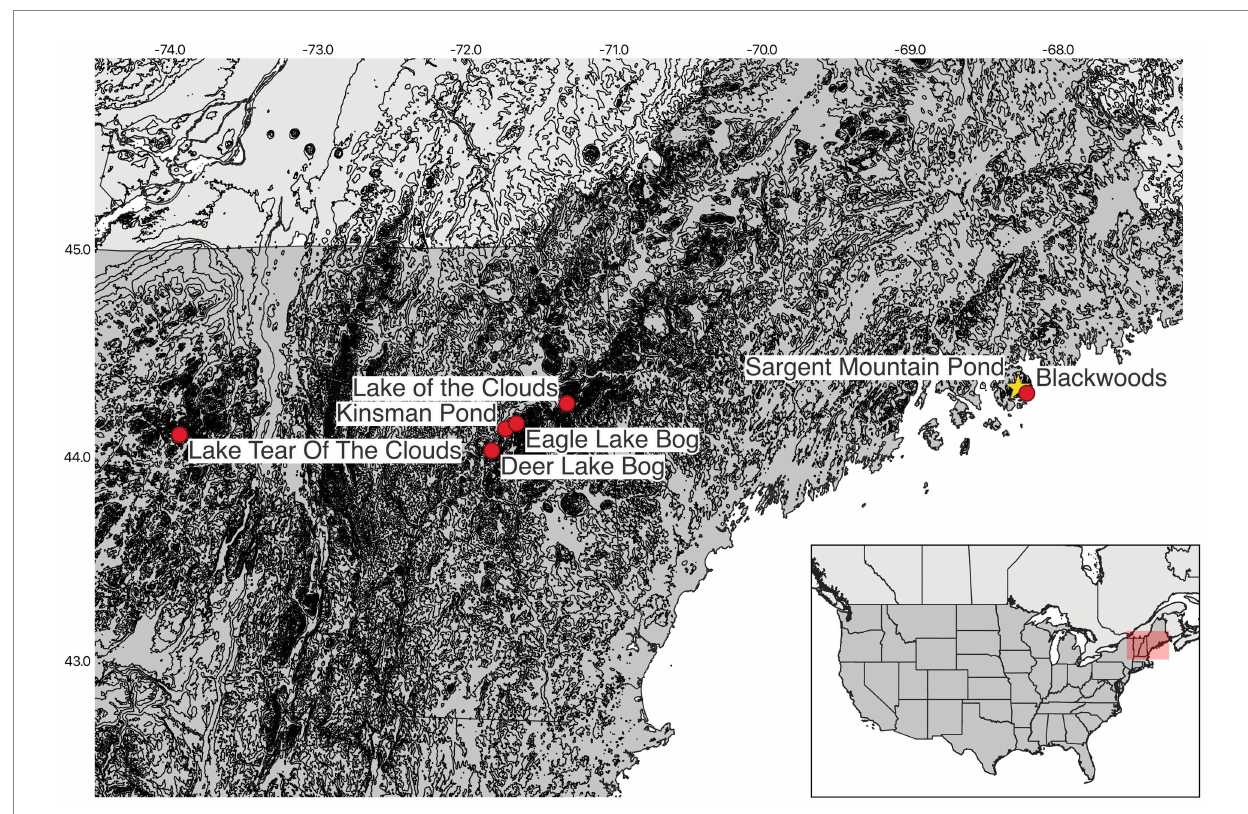
FIGURE 1 Location of all cores referenced in the paper. Red dots are cores referenced in the paper. The yellow star is the location of our core (as well as the location of a separate core collected by Norton et al. (2011) for limnological analyses). Cores include: Lake Tear of the Clouds (Jackson and Whitehead, 1991); Kinsman Pond, Deer Lake Bog, Eagle Lake Bog, and Lake of the Clouds (Spear, 1989; Spear et al., 1994; Miller and Spear, 1999); Blackwoods (Schauffler and Jacobson, 2002); Sargent Mountain pond (Norton et al., 2011) this